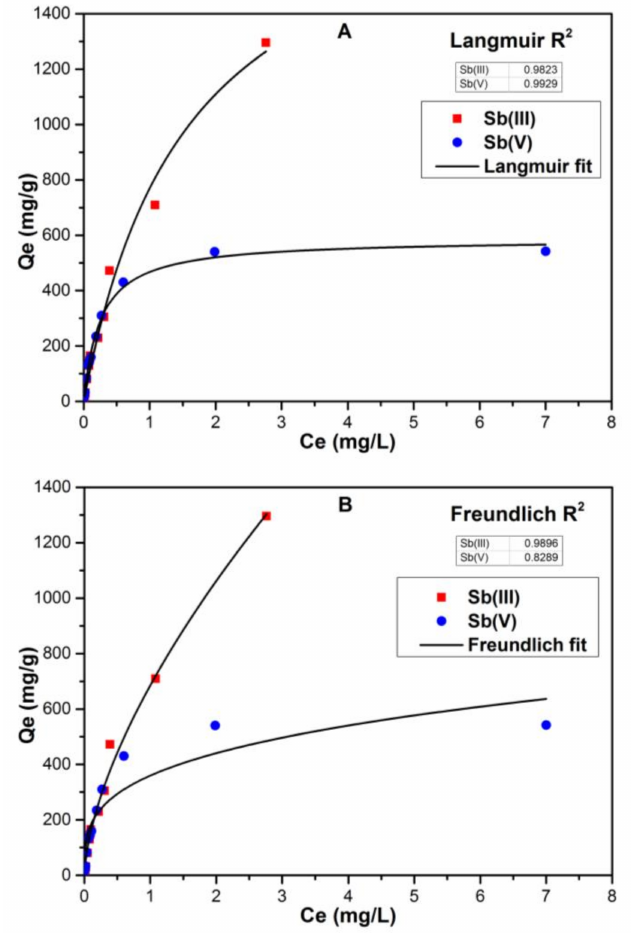
Figure 3. Adsorption isotherms for adsorption of Sb(III) and Sb(V) onto Fe precipitates (5.585 mg/L) at pH 7 and initial Sb concentrations: 0.1 to 10 mg/L. The symbols indicate the experimental results and the solid lines represent the non-linear fitting for ( A ) Langmuir adsorption; ( B ) Freundlich adsorption